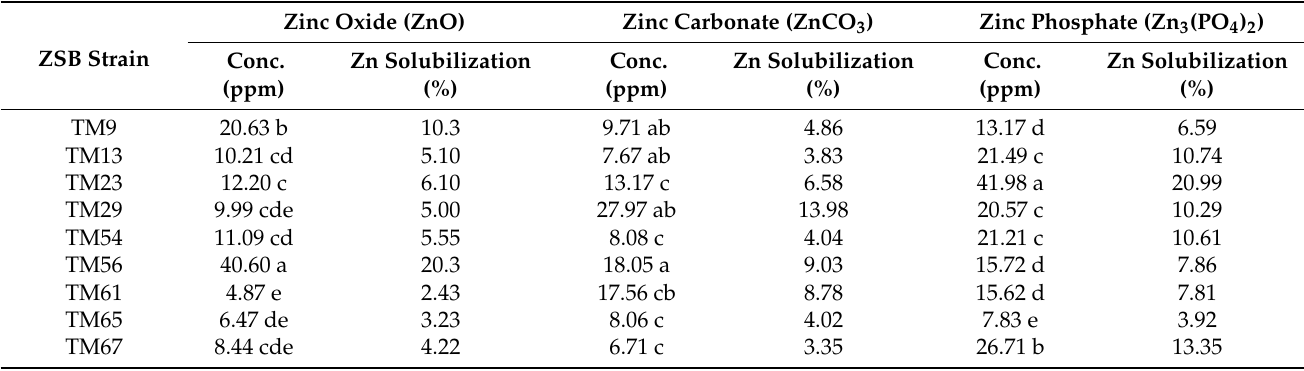
Table 5. Zn solubilization by ZSB in various insoluble Zn mineral-supplemented salts after 48 h of